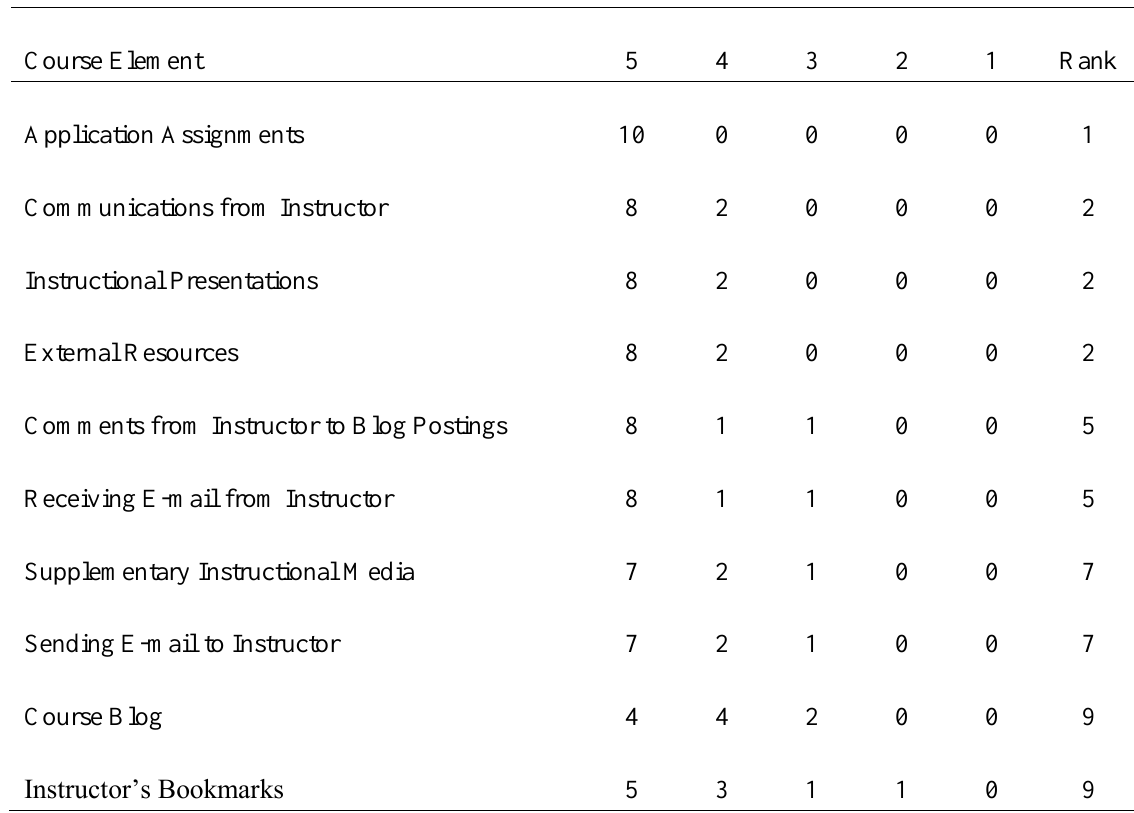
Response Frequencies Most